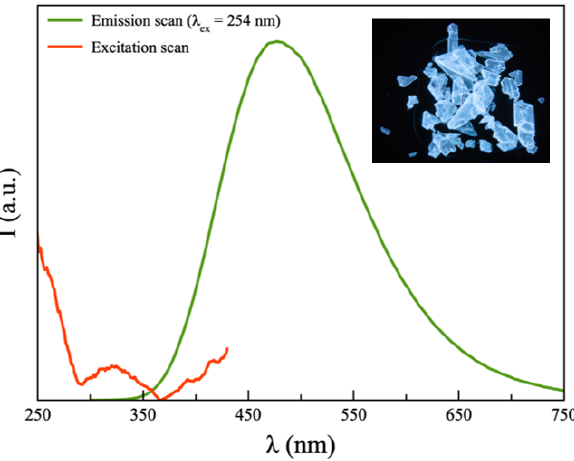
Figure 4. Photoluminescence spectra and optical image of Rb 4 Ge 5 O 9 F 6 :Nb crystals under UV light. Crystals of Rb 4 Ge 5 O 9 F 6 :Nb were also found to scintillate upon exposure to X-rays (Cu K α radiation) and the blue scintillation is shown in Figure 5. The scintillation response